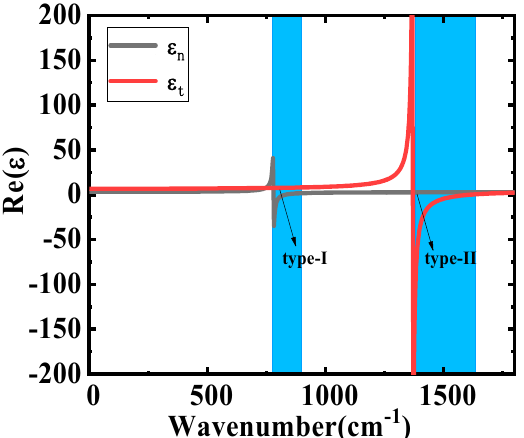
Figure 1. Stereograph and sectional schematics of the structures: ( a ) 3D layout waveguide structure; and ( b ) cross-section structure.